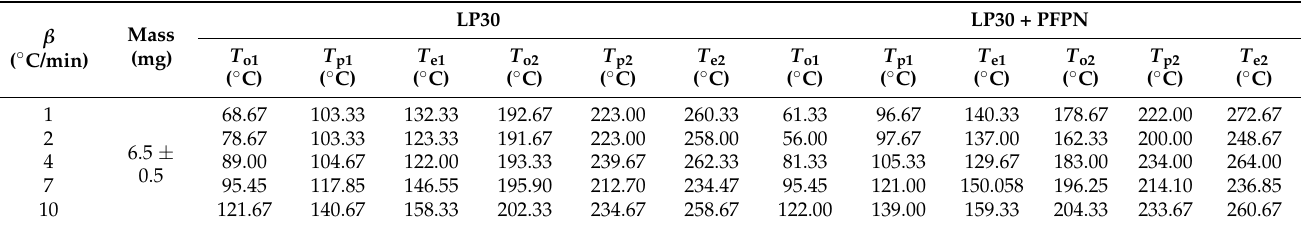
Table 2. Characteristic parameters of LP30 and LP30 + PFPN.